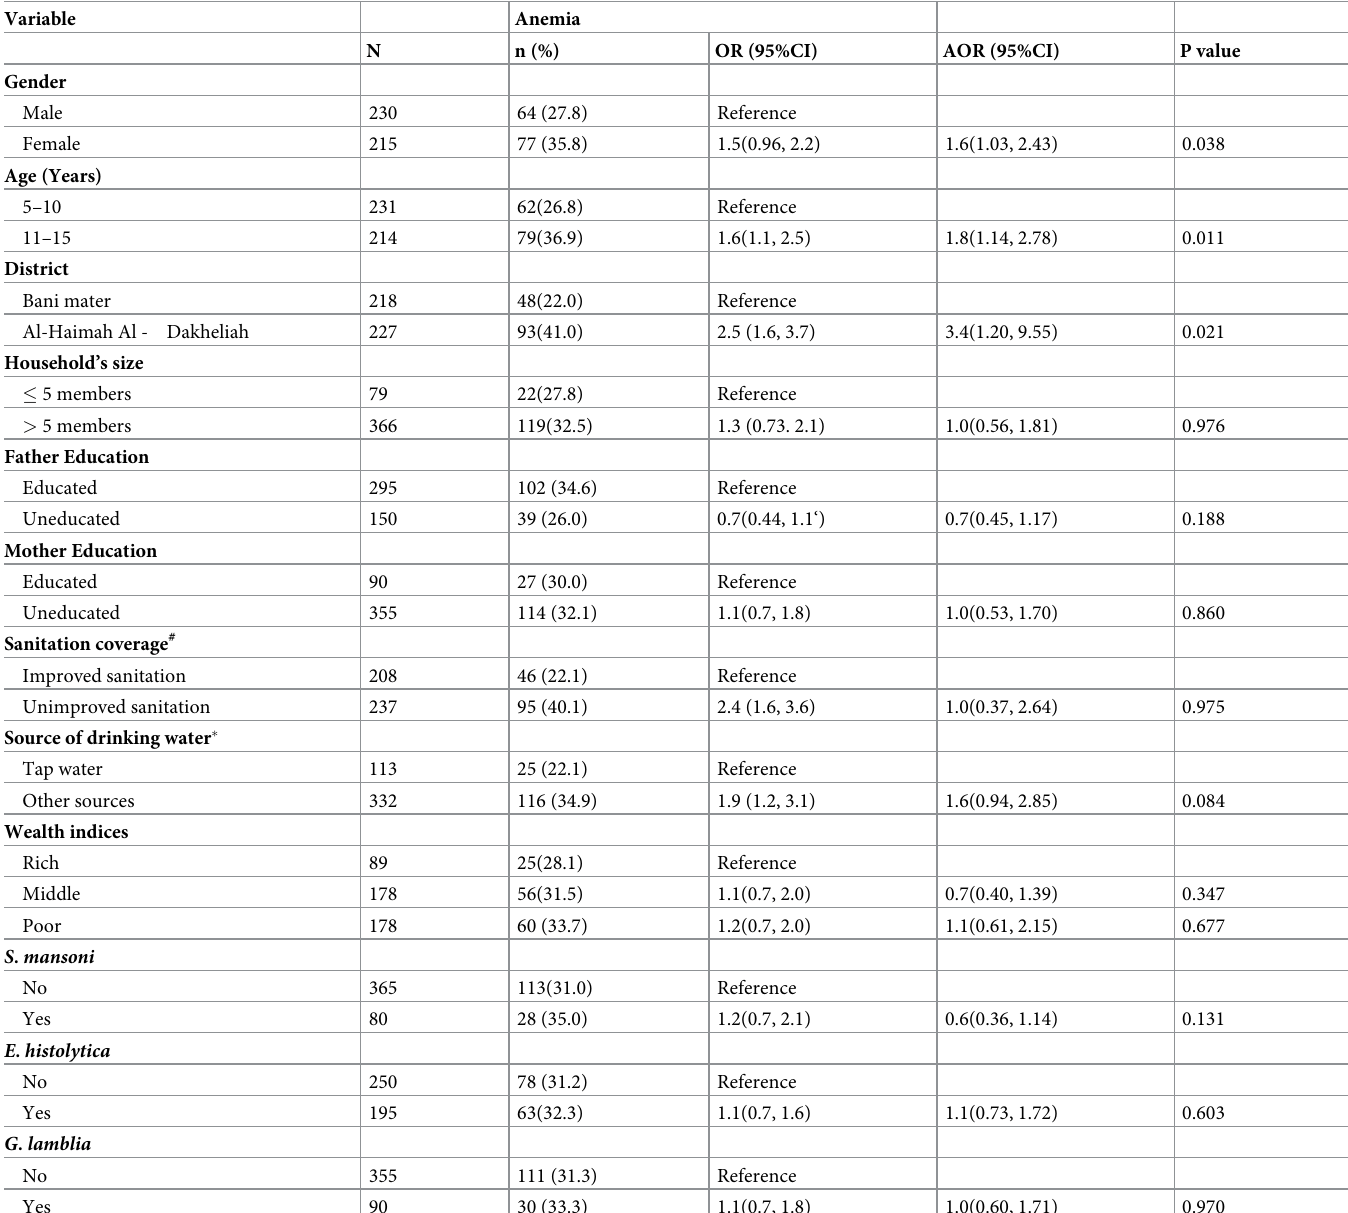
Table 8. Factors associated with anemia schoolchildren in Sana’a Governorate, Yemen (N = 445).